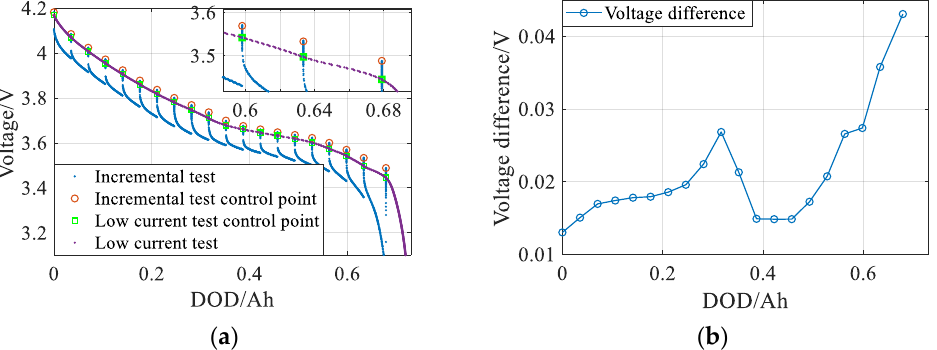
Figure 4. ( a ) Incremental test and low current test results. ( b ) Voltage difference between the two test control points.